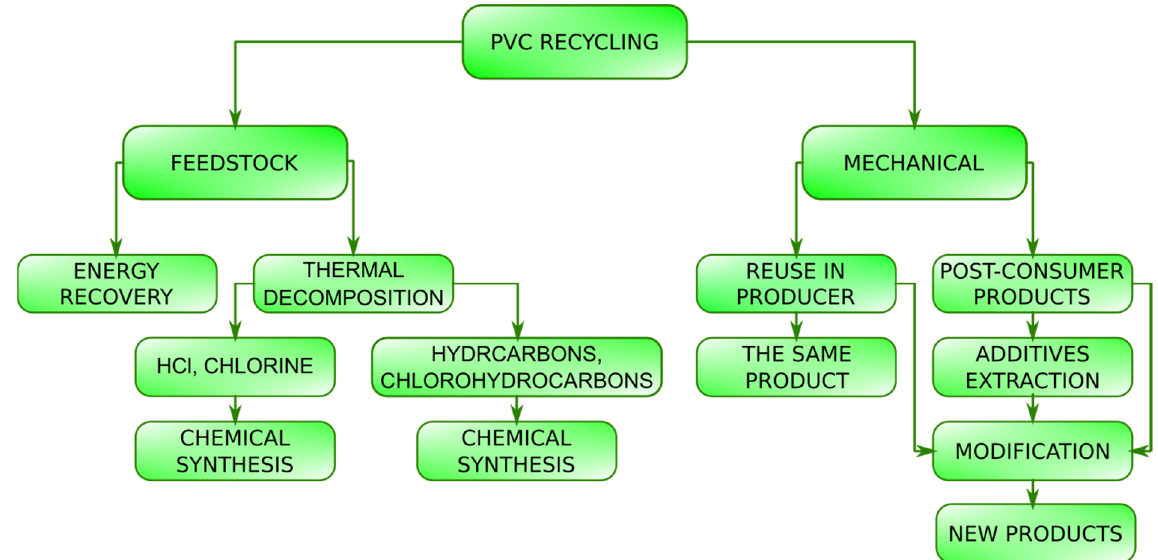
Figure 2. Simplified scheme of poly(vinyl chloride) recycling system.